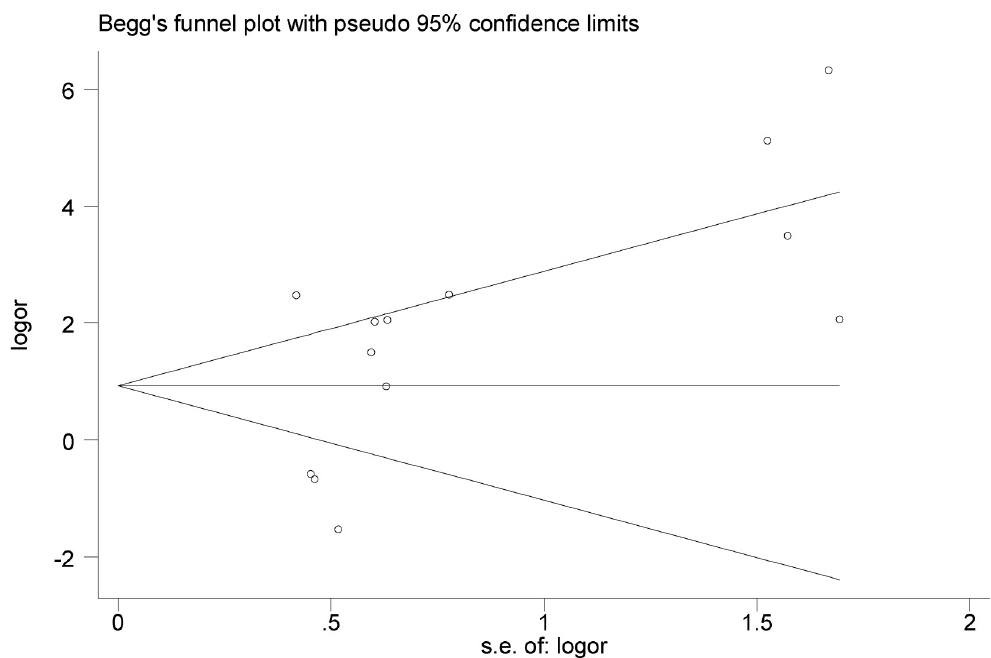
Fig 5. Funnel plot for publication bias regarding the association between EBV infection and OSCC